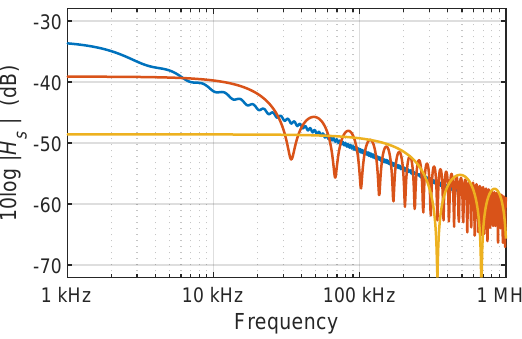
Figure 2. Backscattering transfer function 10log | H s ( f ) | of SMF at 1.55 µ m for different fiber lengths: 30 km (blue), 3 km (orange), and 300 m